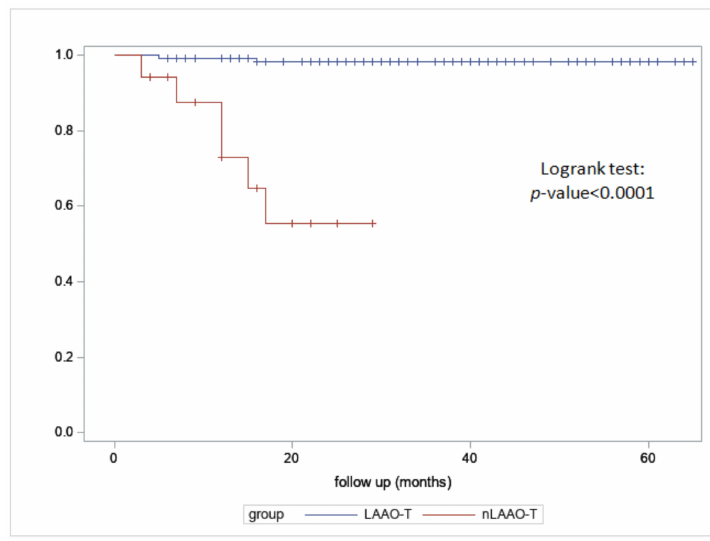
Figure 4. Kaplan–Meier for stroke for LAAO-T and